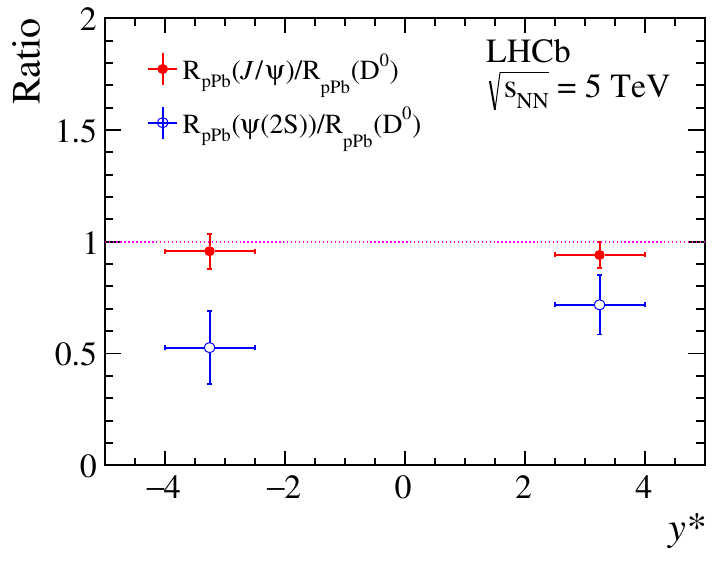
Figure 7 . Ratio of nuclear modi(cid:12)cation factors R p Pb of J= and (2 S ) to D 0 mesons in bins of rapidity integrated up to p T = 10 GeV =c in the common rapidity range 2 : 5 < j y (cid:3) j < 4 : 0. The uncertainty is the quadratic sum of the statistical and systematic components.